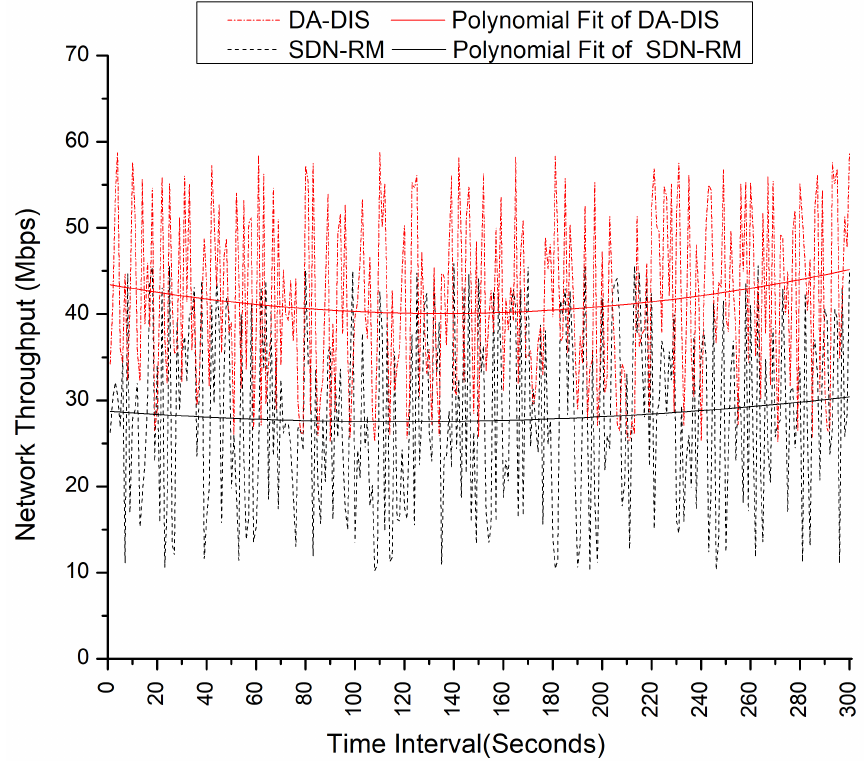
Figure 23. Effect of a malicious switch on throughput during